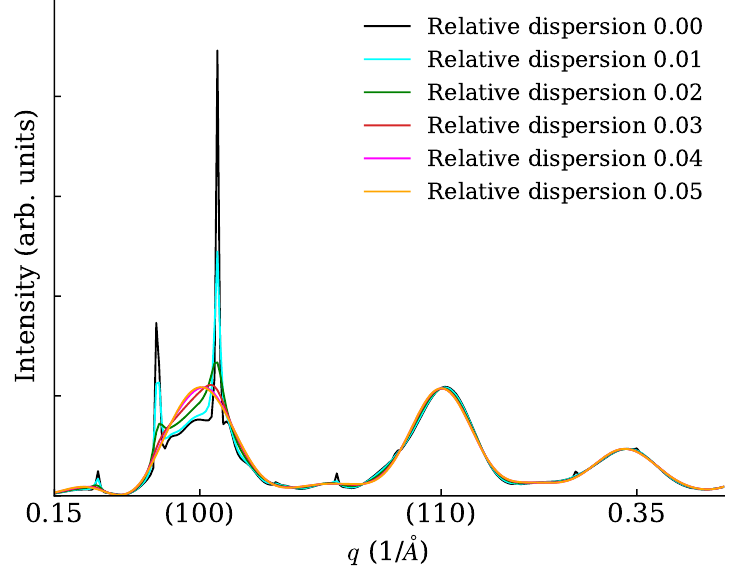
Figure 5. XRPD scattering from a rod (1D SC) with various levels of relative SL spacing dispersion.